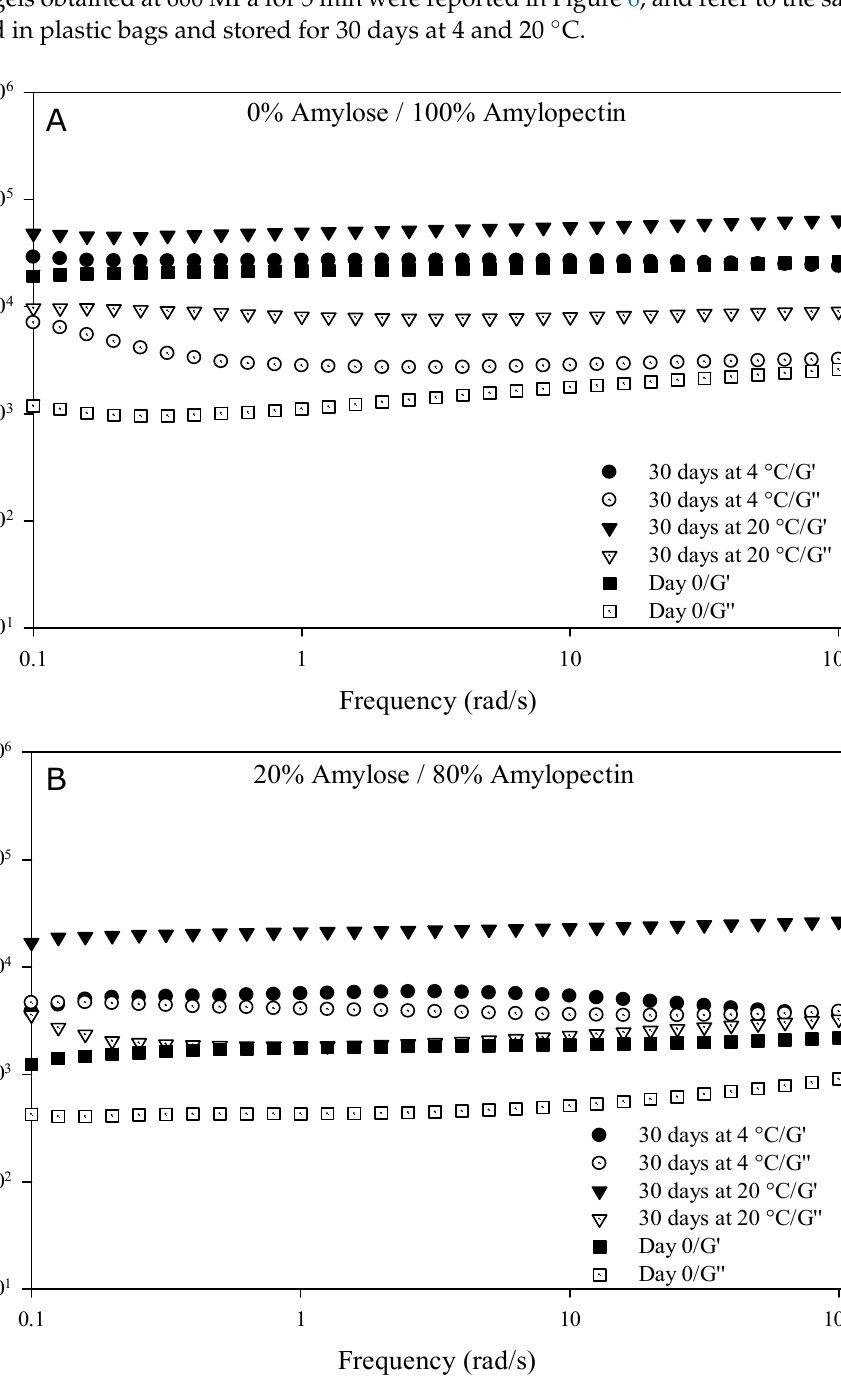
Figure 6. Rheology of corn starch HPP hydrogels with different amylose/amylopectin content at day 0 (immediately after HPP treatment) and after 30 days of storage in plastic bags at 4 °C and 20 °C. ( A ) waxy corn starch; ( B ) normal corn starch.